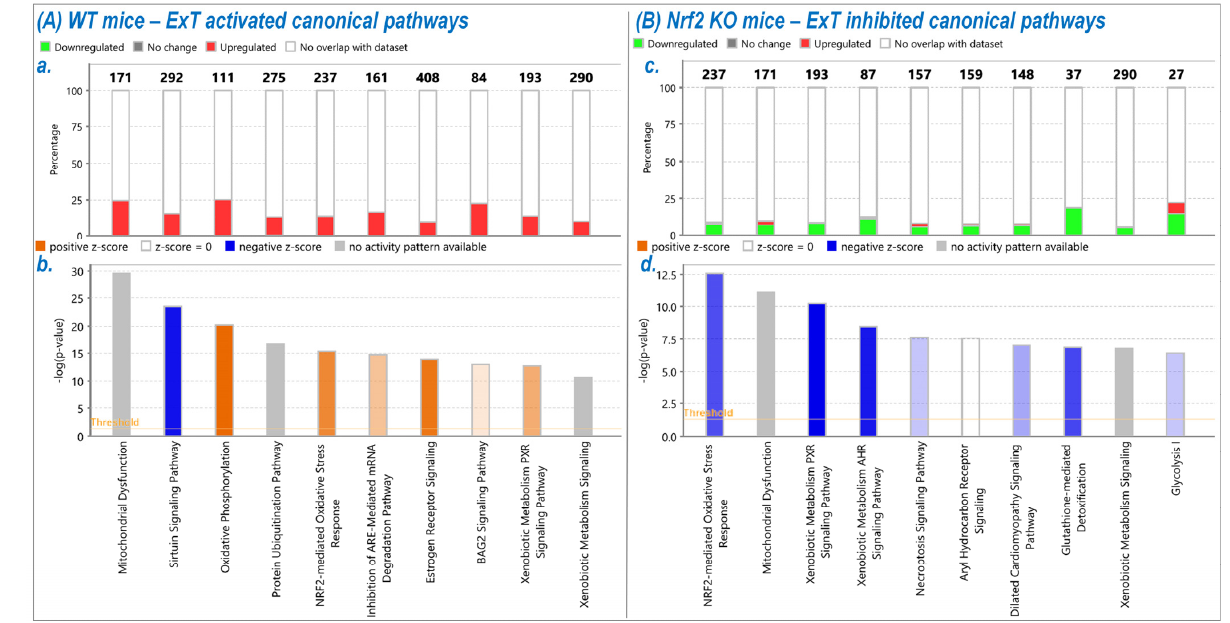
Figure 4. Stacked bar charts displaying the top 10 canonical pathways found to be differentially represented in comparing protein expression between ExT and Sed groups of WT mice ( A ) and Nrf2-KO mice ( B ). The bars are sorted so that the most significant pathways are at the left of the chart. ( a , c ) The total number of genes in each pathway is displayed above the bar. Percentage was calculated by dividing the number of identified genes by the total number of genes that map to the same pathway. ( b , d ) The pathway name is indicated under bar. The significance p -values are calculated by the right-tailed Fisher’s Exact Test, such that taller bars equate to increased significance.